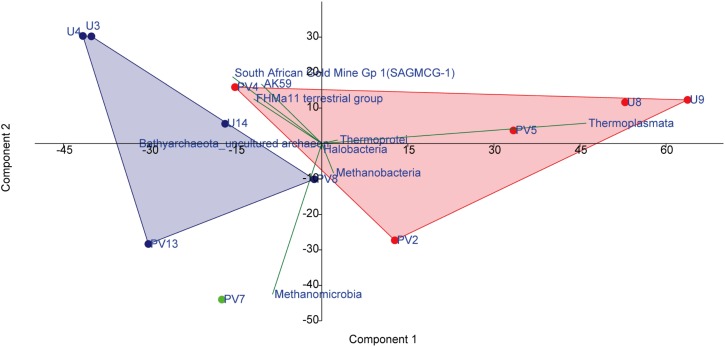
PCA analysis on the basis of the abundance of archaeal classes present among different samples. Red symbols represent basaltic samples; green symbol represents transition zone sample; blue symbol represents granitic samples.